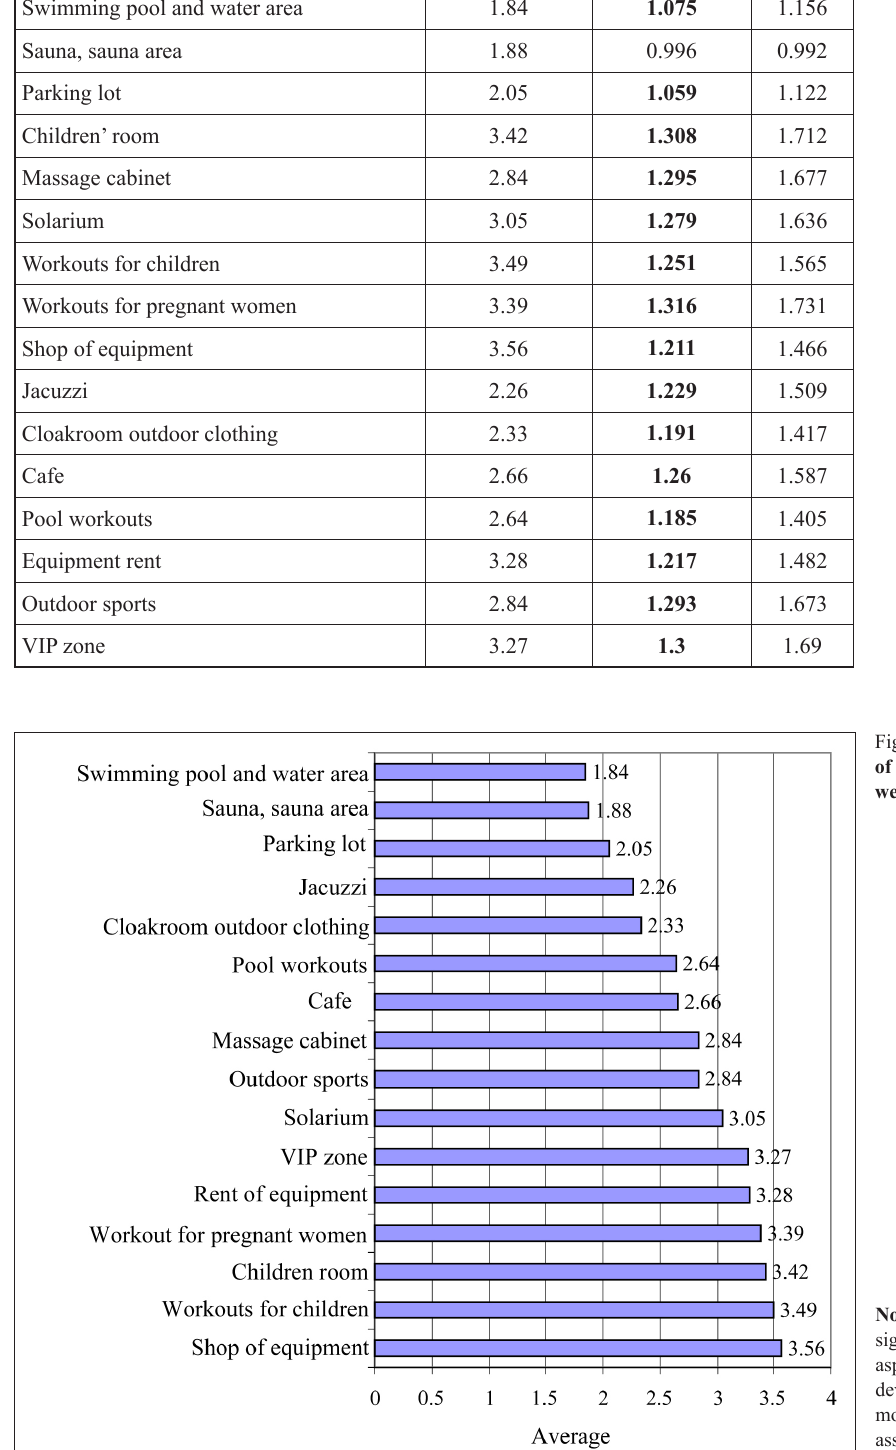
Table 3. Significance assessment of consumers’ service in wellness- fitness centres in